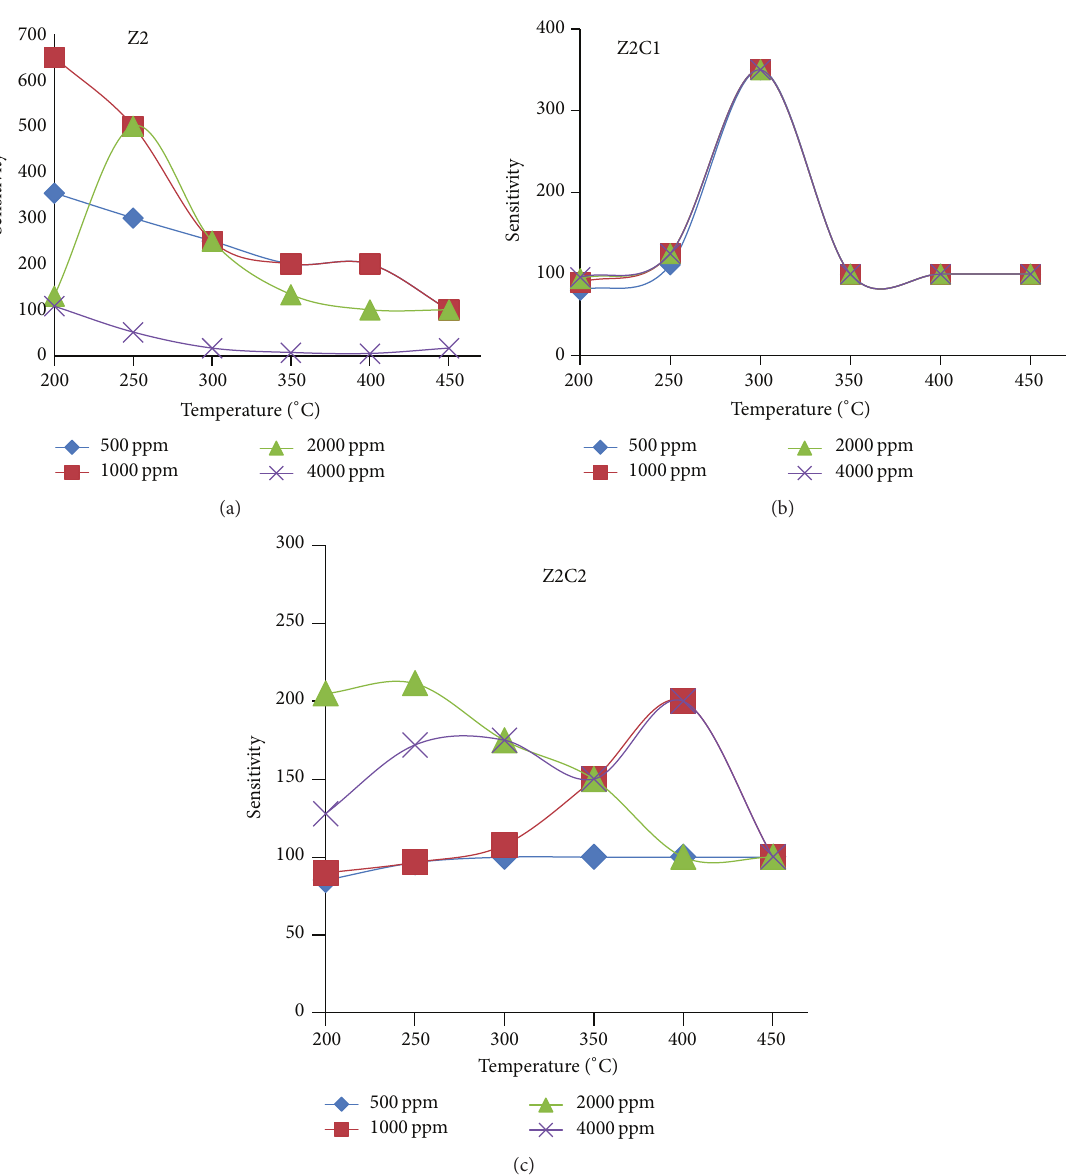
Figure 9: Variation of sensitivity of undoped and Cu doped ZnO thin film samples at various CO 2 concentrations with temperature. Here (a), (b), and (c) correspond to samples Z2, Z2C1, and Z2C2, respectively, prepared using precursor solution of molarity